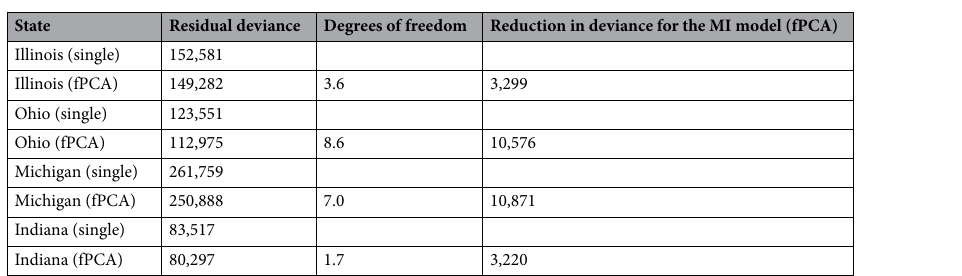
Table 3. Analysis of deviance table comparing the goodness of fit between the MI model (fPCA) and the fraction of devices leaving home (single) of the four states. Degrees of freedom shown is for the χ